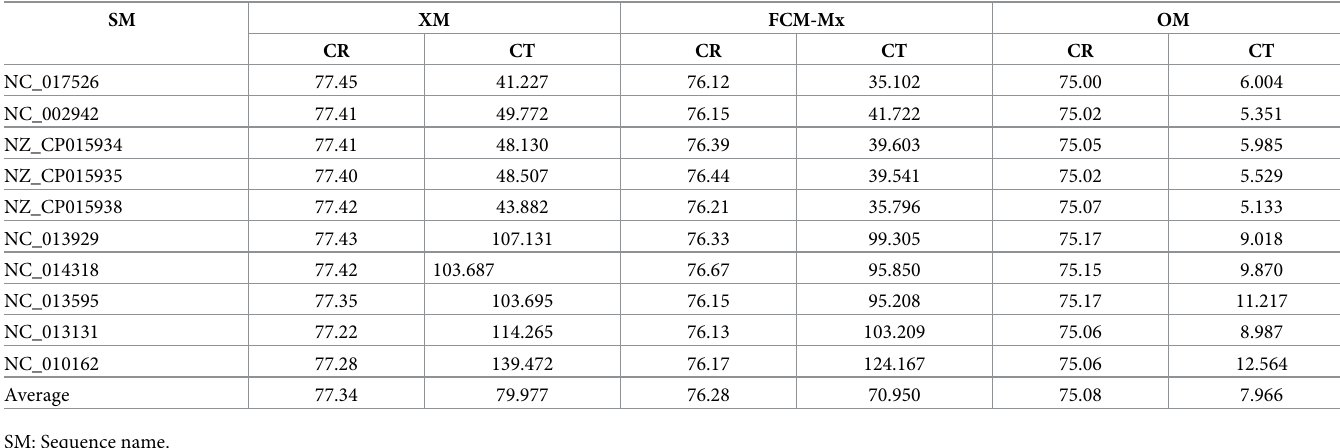
Table 3. Compression benchmarks for state-of-the-art pure genomic compression